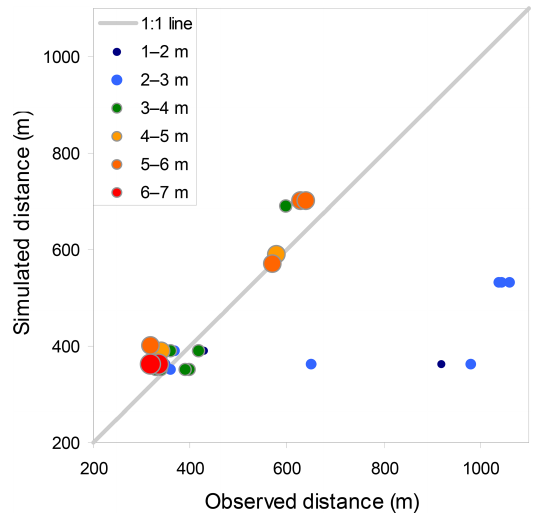
Figure 5. Field-observed distance from the source and maximal simulated travel distances of rock blocks. Block diameters are both size- and color-coded. The 1 : 1 line ( x = y ) is plotted in gray.